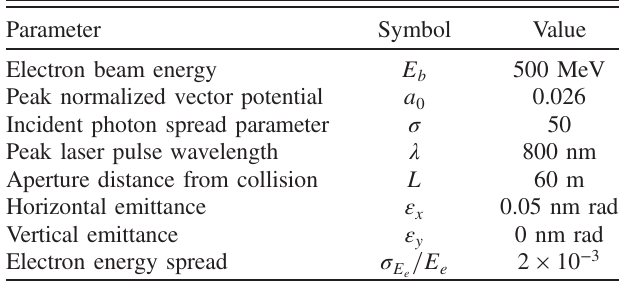
TABLE I. Electron beam and incident laser pulse parameters used in through-aperture spectra calculation.